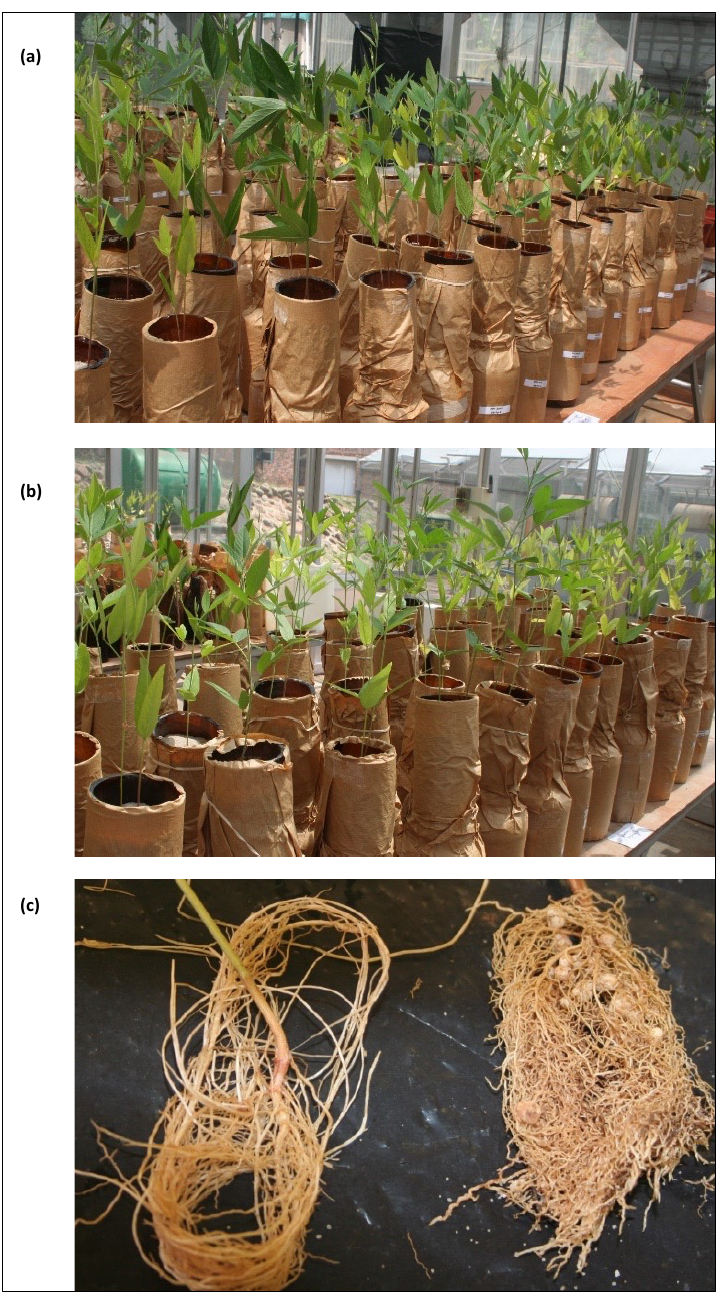
Figure 1. Pigeonpea plants of the ( a ) local landrace genotype PP1-3018 and ( b ) the exotic improved genotype PP5-3021. Genotype PP1-3018 appears a much healthier with a dark green color, while some of the plants of genotype PP5-3021 appear less healthy with light green/yellow leaves; ( c ) most of the plants with yellow leaves, as well as the uninoculated controls, lacked nodules ( left ) while the healthy-looking plants had roots bearing numerous indeterminate nodules ( right ).